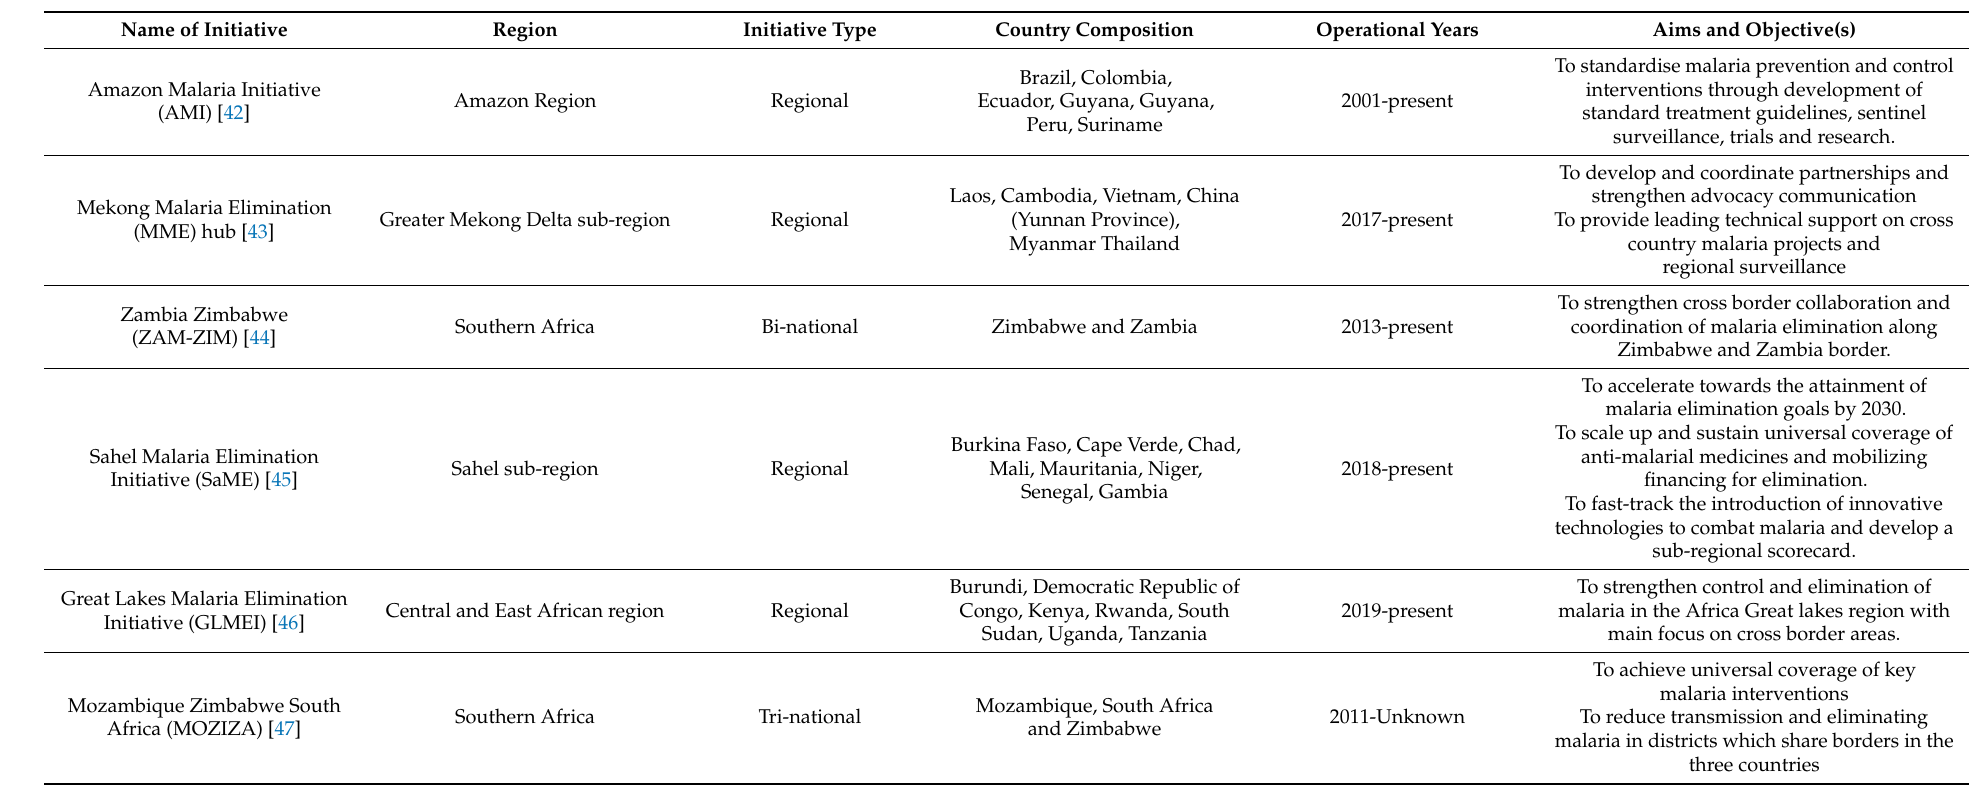
Table 2. Cross-border malaria initiatives with no peer reviewed